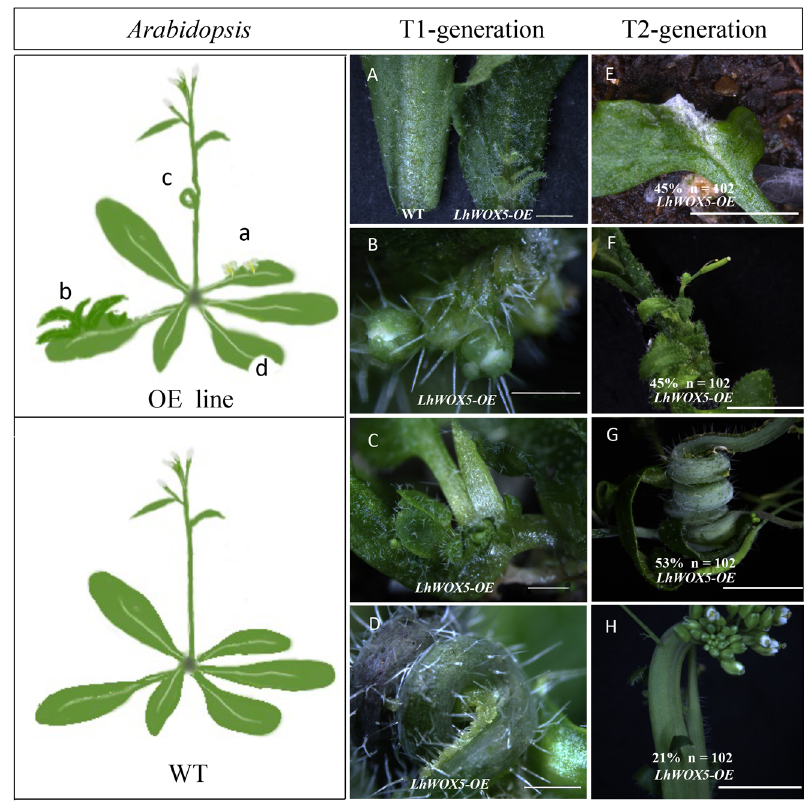
Figure 3. The phenotypes of p35S:LhWOX5 ( LhWOX5-OE) transgenic Arabidopsis . Hand-drawn images showing transgenic (OE line) and wild type (WT) plants. (a) Ectopic flower buds growing on rosette leaf veins. (b) Ectopic leaves growing on rosette leaf veins. (c) Curly stalk. (d) Incomplete cotyledon. ( A – D ) Phenotypes of T1-generation plants. ( A ) rosette leaves of WT and LhWOX5-OE lines. ( B – C ) Ectopic leaves and/or flower buds growing from rosette leaf veins. ( D ) A curly stalk with undetermined hyperplasia at the curling site. ( E – H ) Phenotypes of T2 generation plants. ( E ) Incomplete cotyledon. ( F ) A rosette leaf with ectopic leaves, flower buds, and pods growing on its leaf veins. ( G ) Curly stalk with undetermined hyperplasia. ( H ) Fused stalk. Scale bar = 0.5 um.